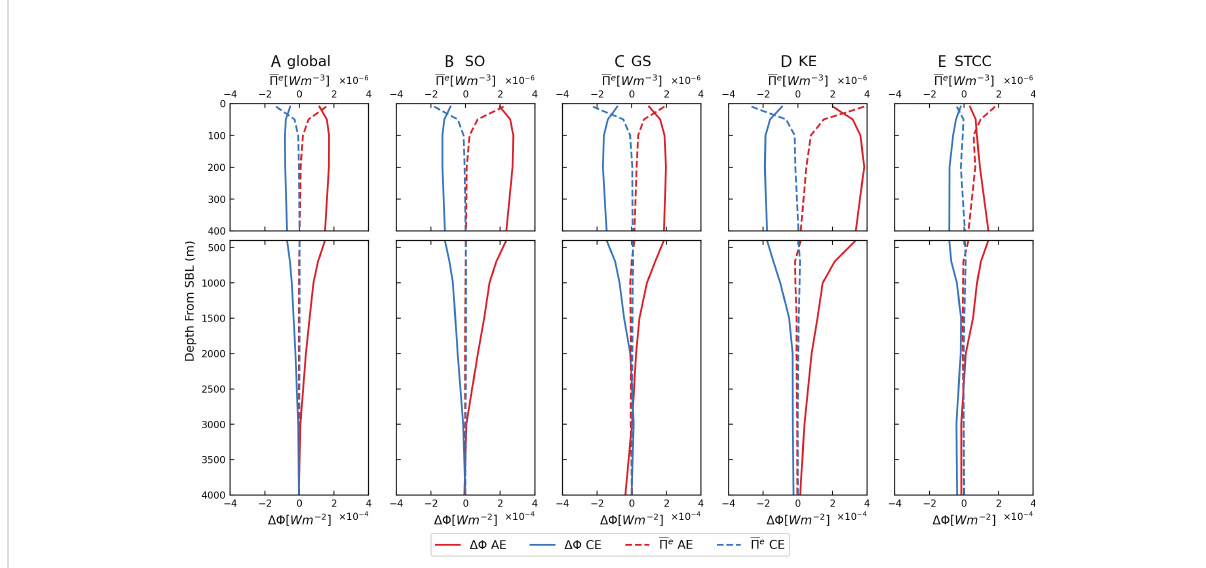
FIGURE 6 Composites of DF (solid lines) and P e (dashed lines) in AEs (red lines) and CEs (blue lines) in the (A) global ocean, (B) SO, (C) GS, (D) KE, and (E) STCC,